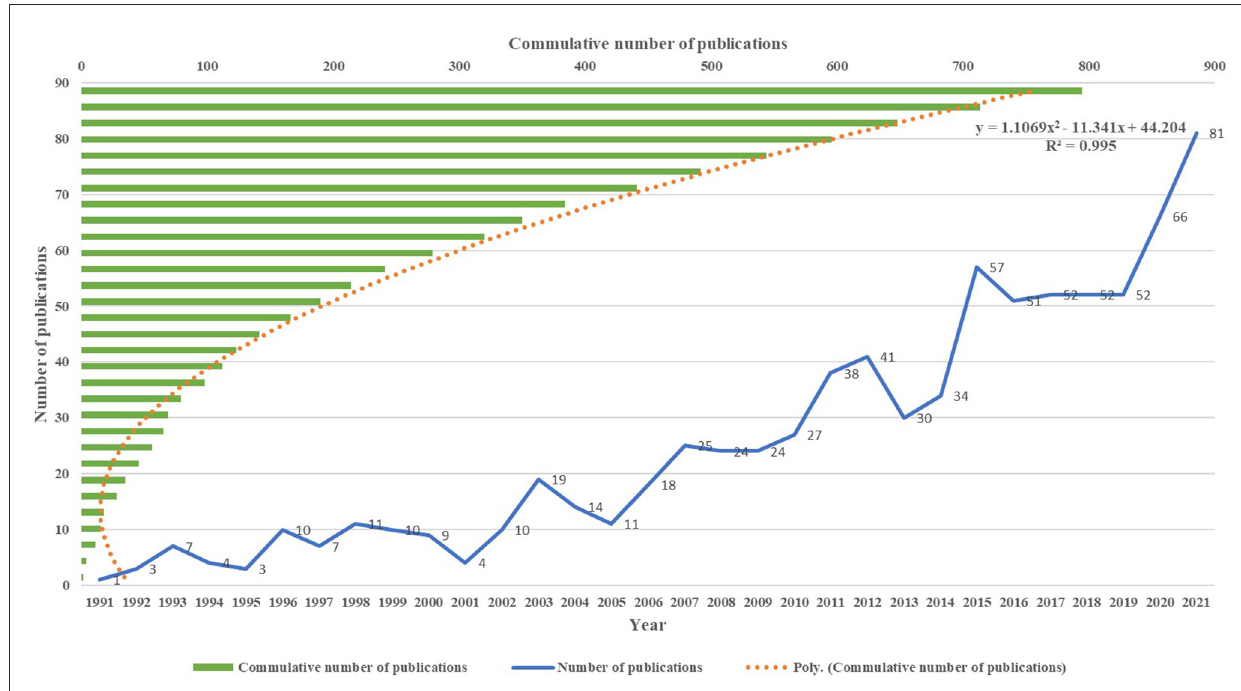
FIGURE2 The trend of publication outputs from 1991 to 2021 on the rehabilitation of rotator cuff injury.